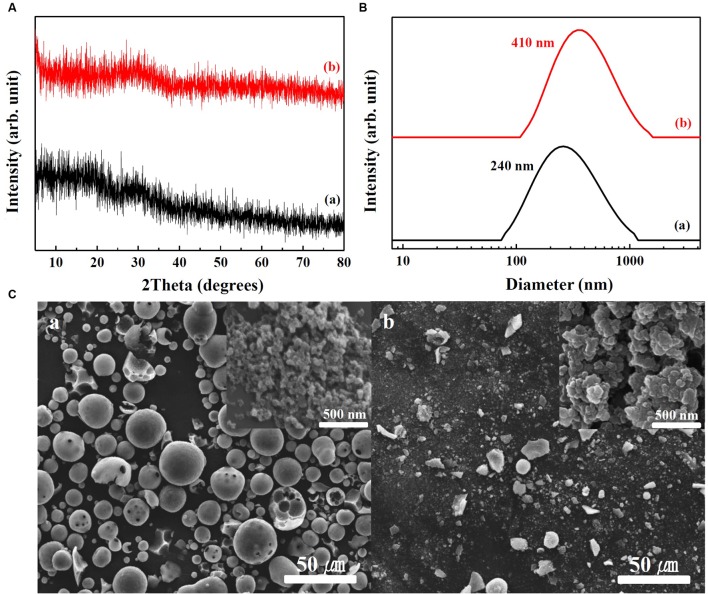
(A) XRD patterns, (B) hydrodynamic radii measured by DLS, and (C) SEM images of (a) SunActive FeTM and (b) FePP. Insets in (C-a,b) are magnified images at the surface of materials.